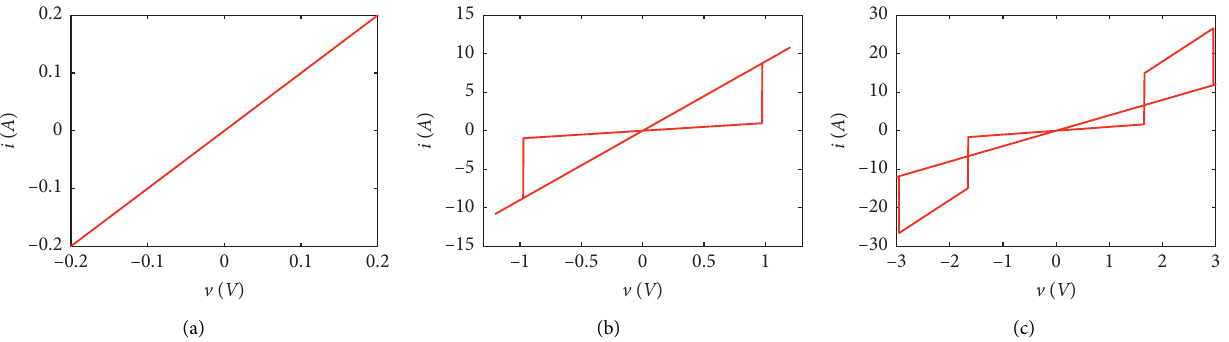
Figure 3: v-i curve of the tri-valued memristor at different amplitudes: (a) v –20–1001020 A ) ( i